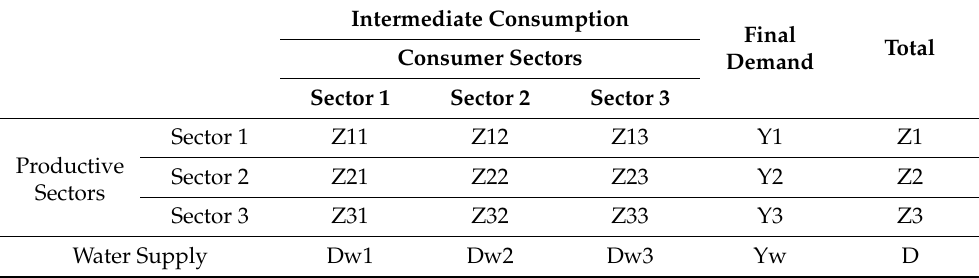
Table 1. Input-Output Matrix model after the incorporation of the water